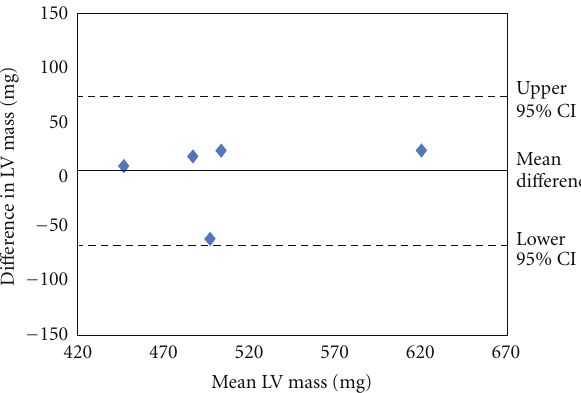
Figure 2: Bland-Altman analysis showing agreement between MR measurement and post-mortem measurements of LV mass in healthy rats. The analysis revealed mean di ff erence of 2mg (solid line) and 95% confidence interval of 72 mg (mean di ff e- rence ± 1.96 × standard deviation). CI: confidence